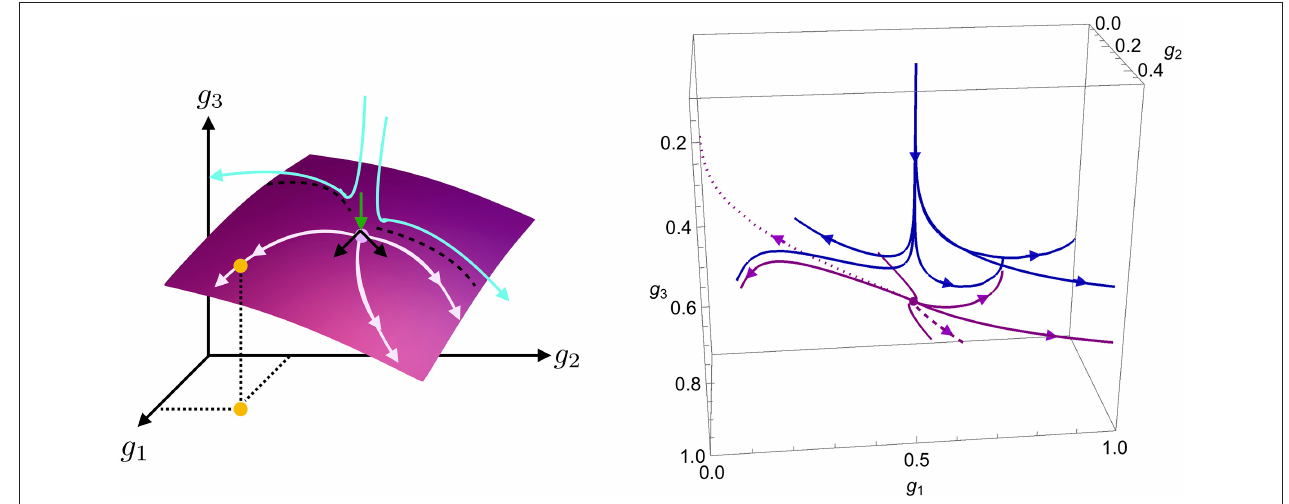
FIGURE 2 | Left panel : Illustration of a fixed point (light purple dot) with its UV critical hypersurface (purple). RG trajectories starting off the critical hypersurface (teal) are pulled toward the fixed point along the irrelevant direction (roughly aligned with g 3 ), before the IR repulsive directions g 1 and g 2 kick in and drive the flow away from the fixed point. The linearized flow is indicated by the black (relevant directions) and green (irrelevant direction) arrows. Right panel : A fixed point with two relevant directions in the space of three couplings g 1,2,3 , where g 3 corresponds to the IR attractive direction. The purple trajectories emanate from the fixed point, and g 2,3 fully determine the deviation from scale invariance. The arrows indicate the RG flow toward the IR. The corresponding beta functions of one canonically marginal, relevant and irrelevant interaction are given by β g